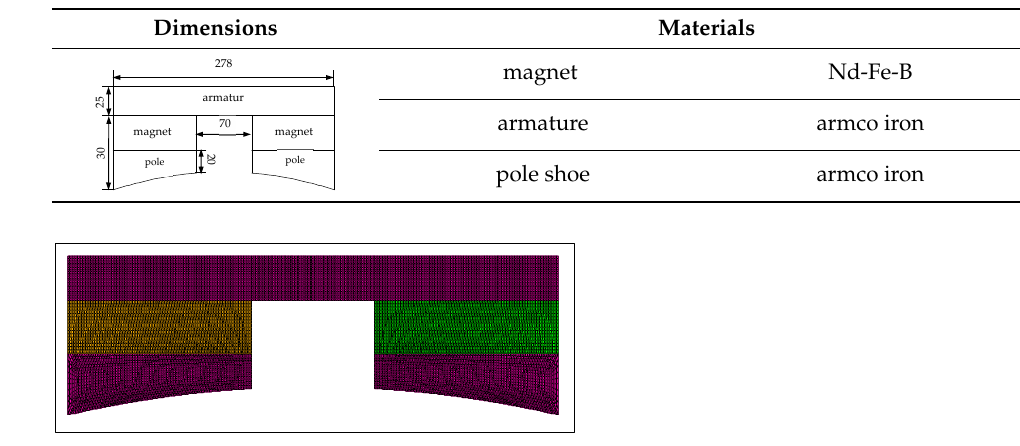
Figure 6. Excitation structure model.